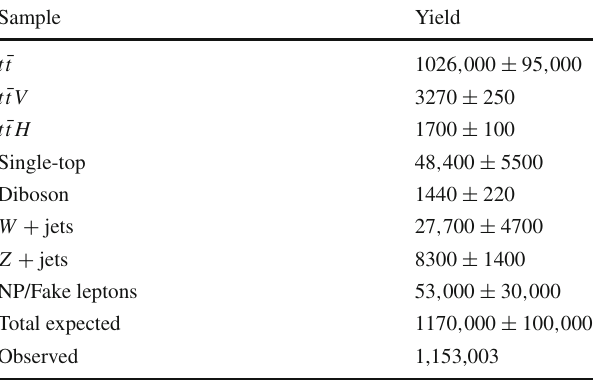
Table 2 Event yields after selection. The uncertainties include experi- mental uncertainties and the uncertainty in the data-driven non-prompt andfakeleptonbackground.Theoreticalcross-sectionuncertaintiesand uncertainties due to limited MC sample sizes are not included. Details of the uncertainties considered can be found in Sect.